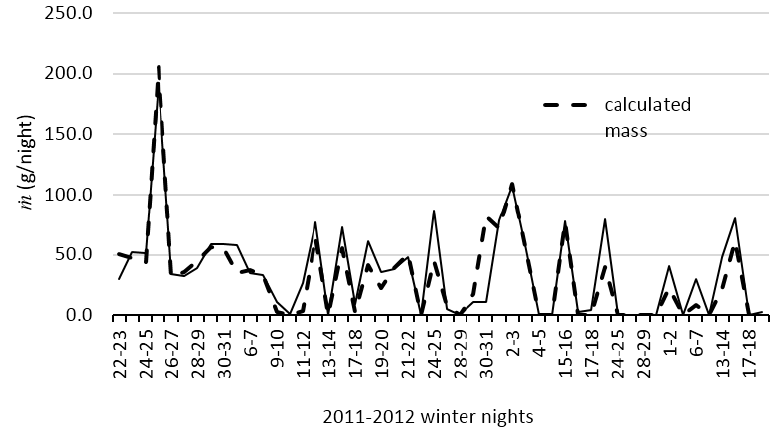
Figure 11. Comparison between the measured and calculated rates of condensation.